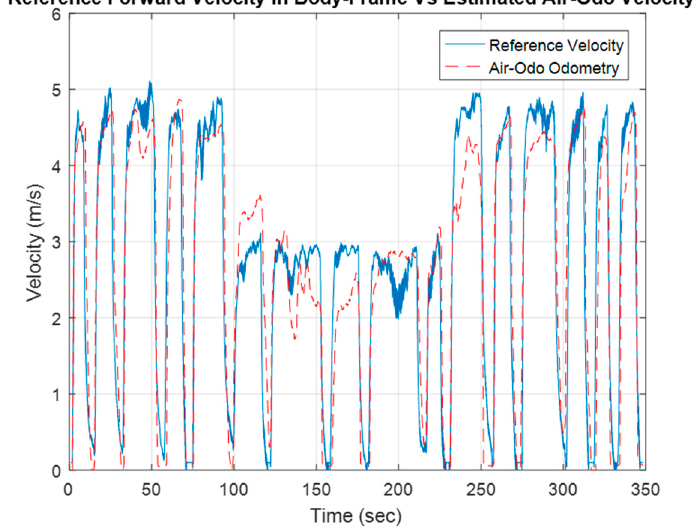
Figure 12. Air-Odo velocity estimate (after compensating for existing wind) compared against reference velocity.